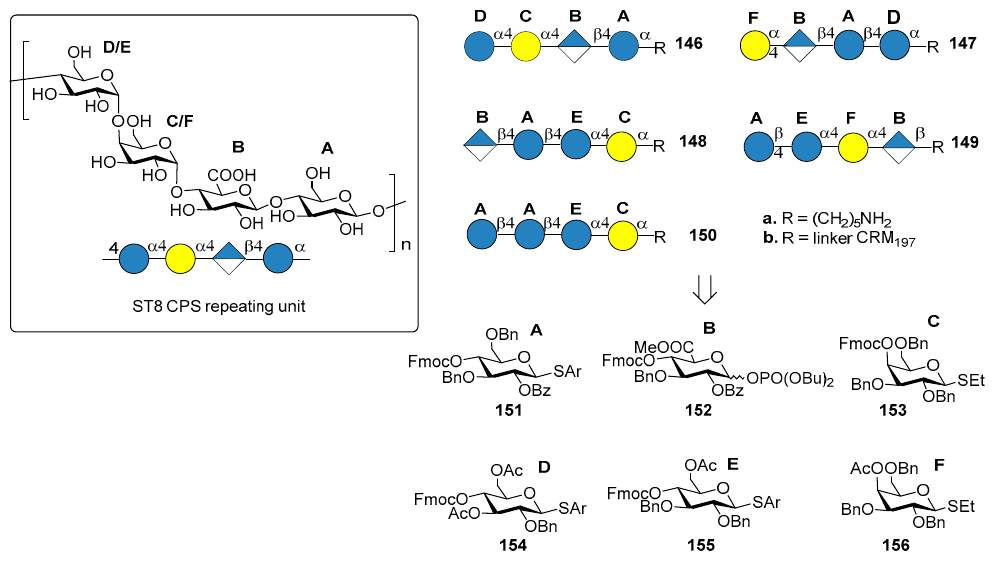
Figure 16. Repeating unit of Streptococcus pneumoniae 8 CPS and synthetic ST8 glycan fragments reported in [92].